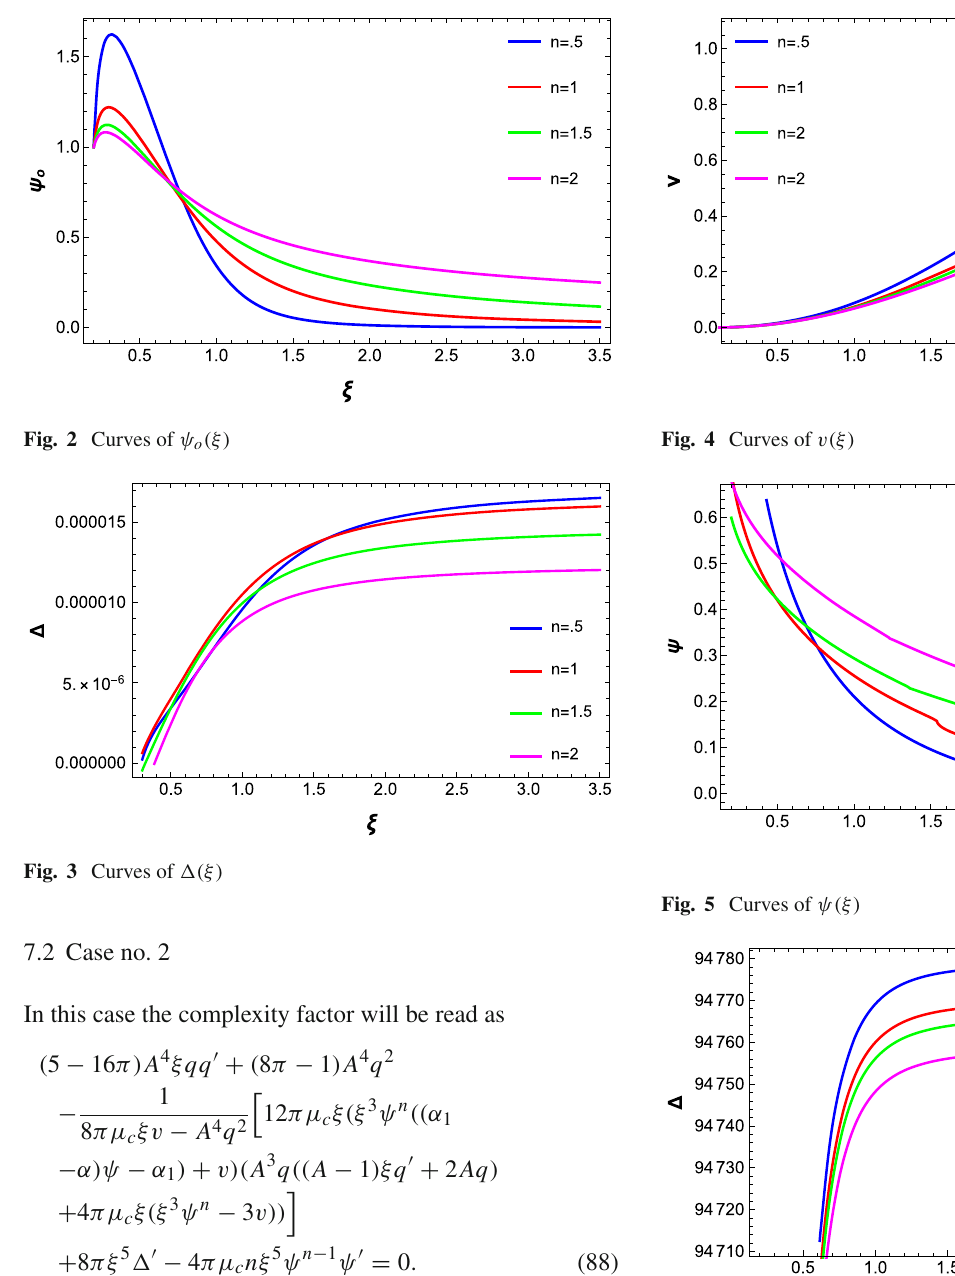
Fig. 5 Curves of ψ(ξ)